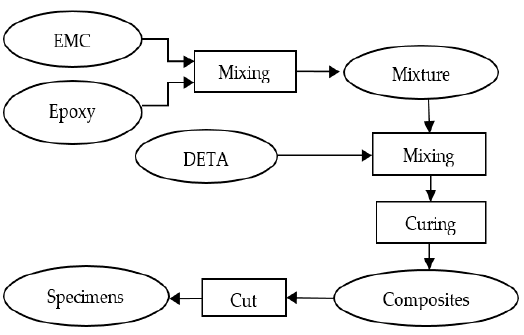
Figure 1. Process flowchart showing the applied fabrication route of EMC/Epoxy composites.